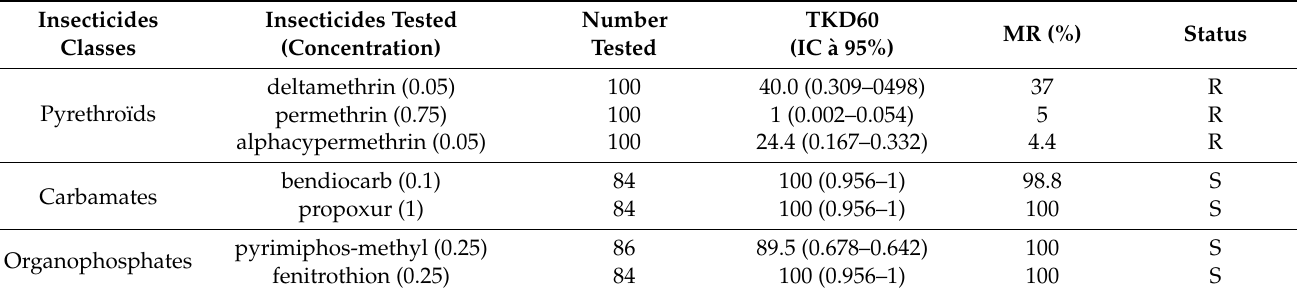
Table 1. Number of mosquitoes tested and mortality rates in An. gambiae s.l. fro Ebolowa following insecticide